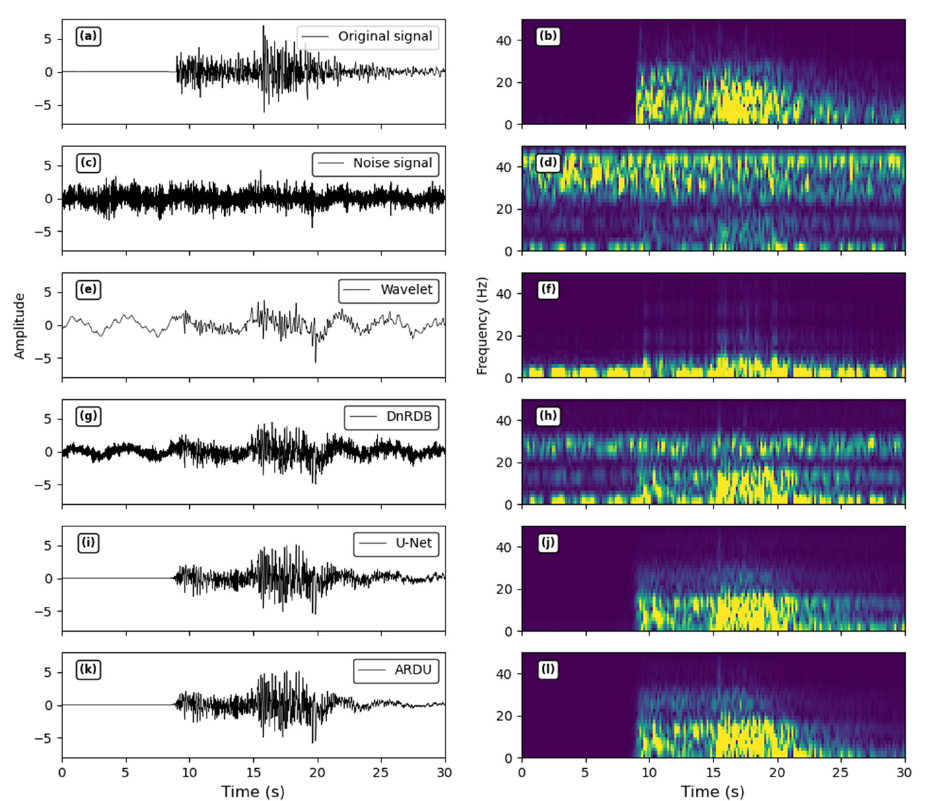
Figure 12. Denoising results of seismic signals with an SNR of − 6 dB using different methods.